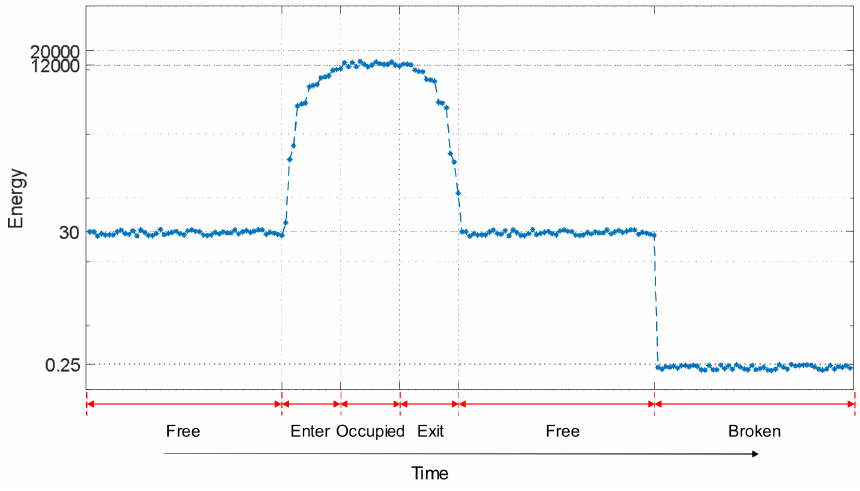
Figure 19. Example of a temporal trend for the feature E i in a certain track section S i .